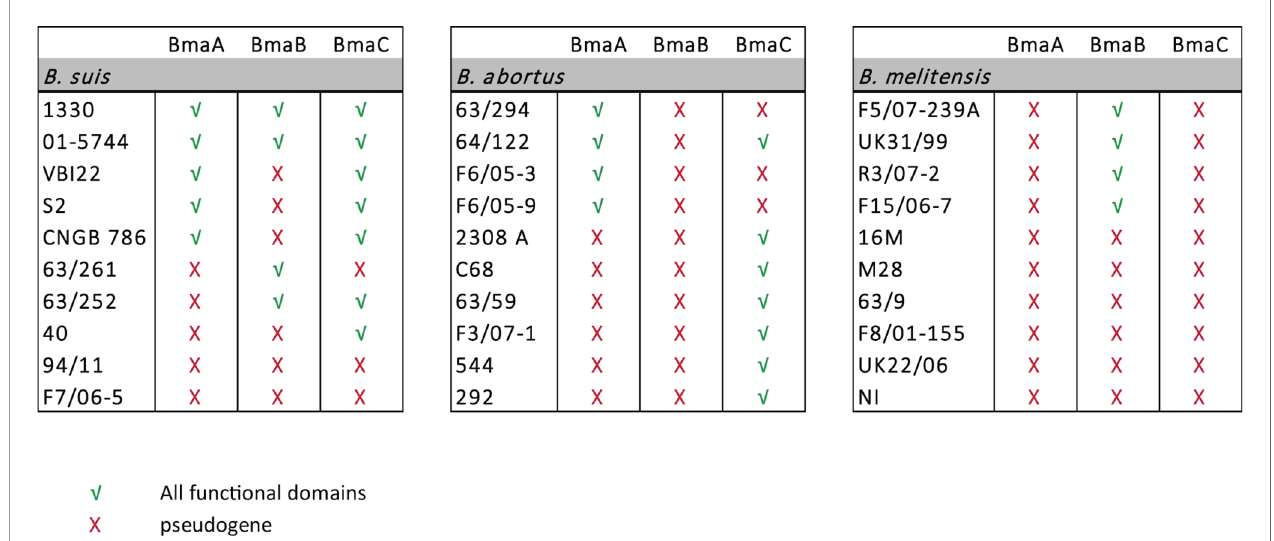
FIGURE 6 | Protein analysis of type Va autotransporters in Brucella spp. Sequence analysis of BmaA, BmaB, and BmaC orthologues in B. suis , B. abortus , and B. melitensis strains. Red cross indicates pseudogene and green tick indicate that both the signal peptide and the b -barrel domain, which are required for proper translocation of the autotransporter through the inner and outer membranes are